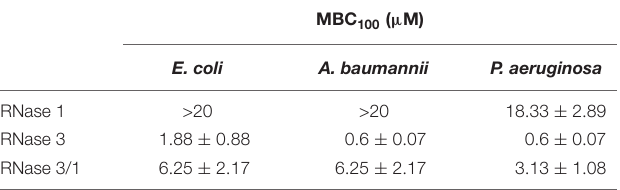
TABLE 1 | Bactericidal activity characterization of RNase3/1.